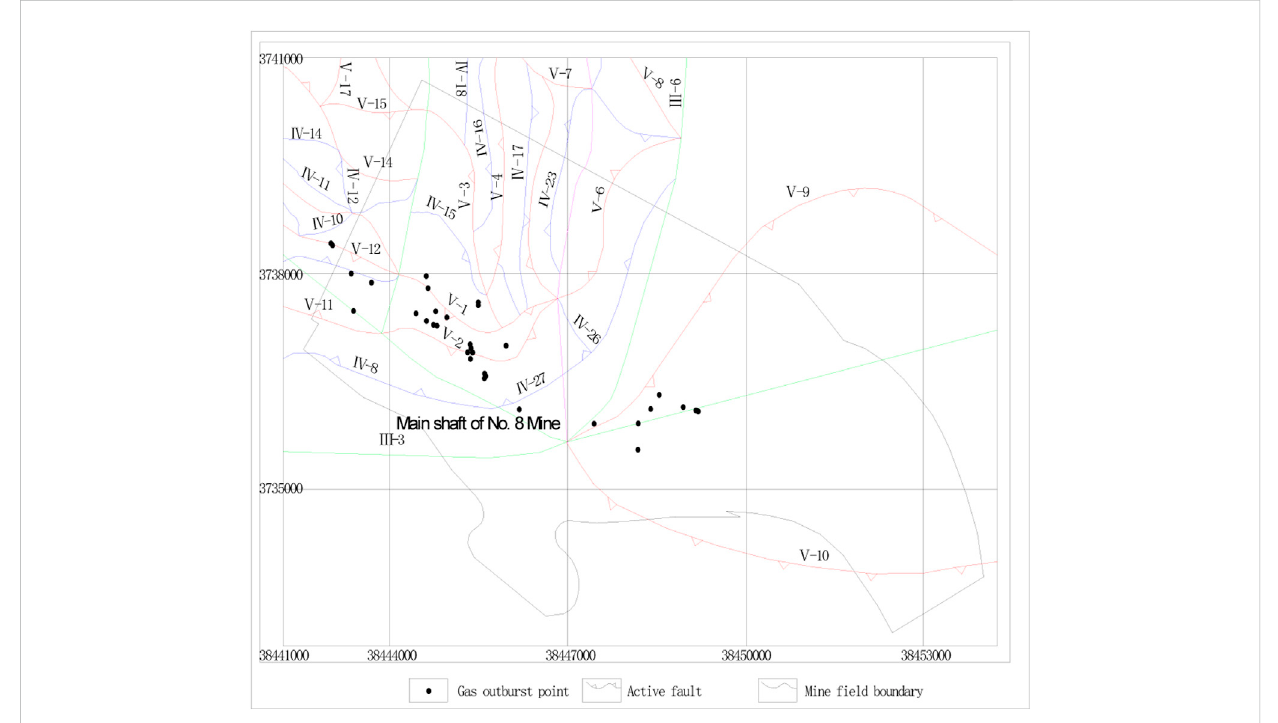
FIGURE 3 Grade VI fault map and spatial distribution map of coal and gas outburst in Pingdingshan No. 8 coal